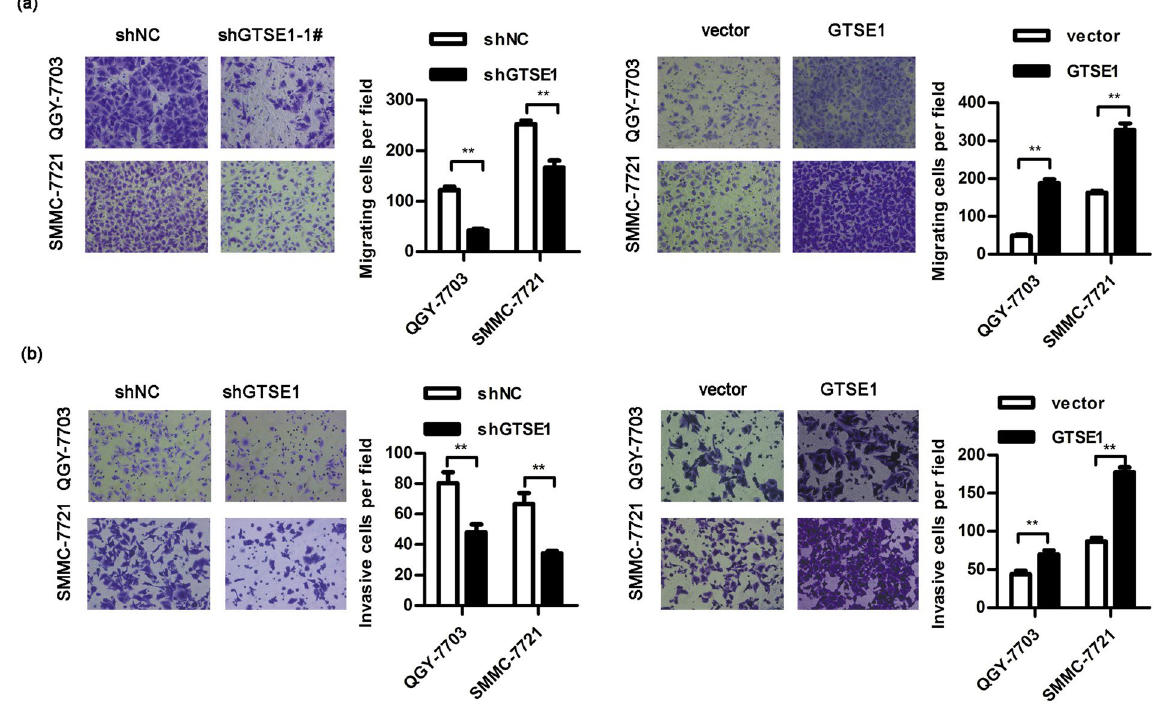
Figure 3. GTSE1 facilitates migration and invasion in vitro . ( a ) The migration assay using QGY-7703 and SMMC-7721 transfected with shGTSE1 or GTSE1 or control. ( b ) The invasion potential of QGY-7703 and SMMC-7721 transfected with shGTSE1 or GTSE1 or control. Statistical method: independent t -test.